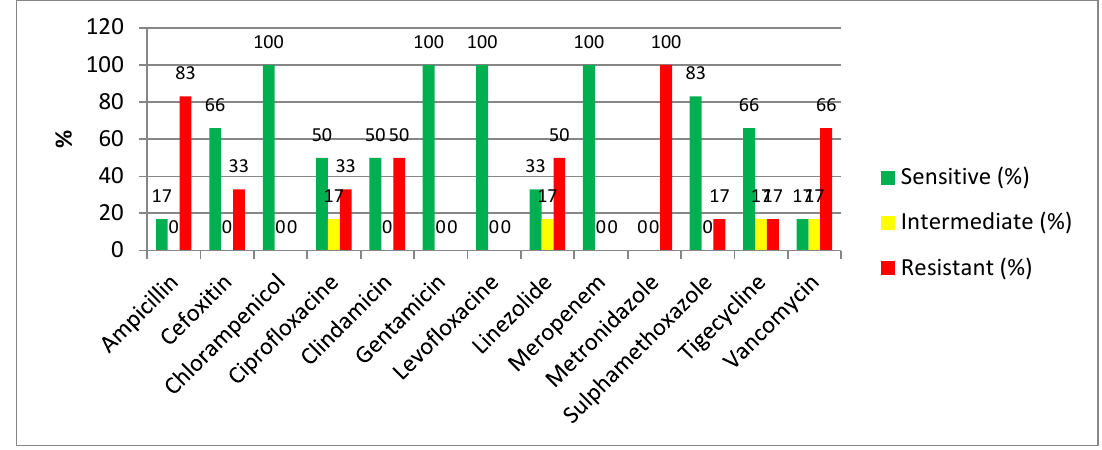
Fig. 2. Antibiotic sensitivity pattern of staphylococcus aureus (n=6).